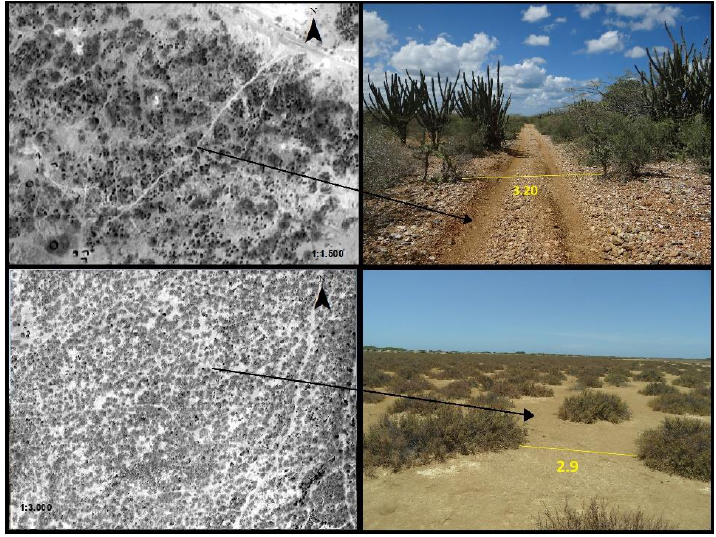
Figure 10. Distance measurements between leopard patches on the ground and the satellite image Eros B.